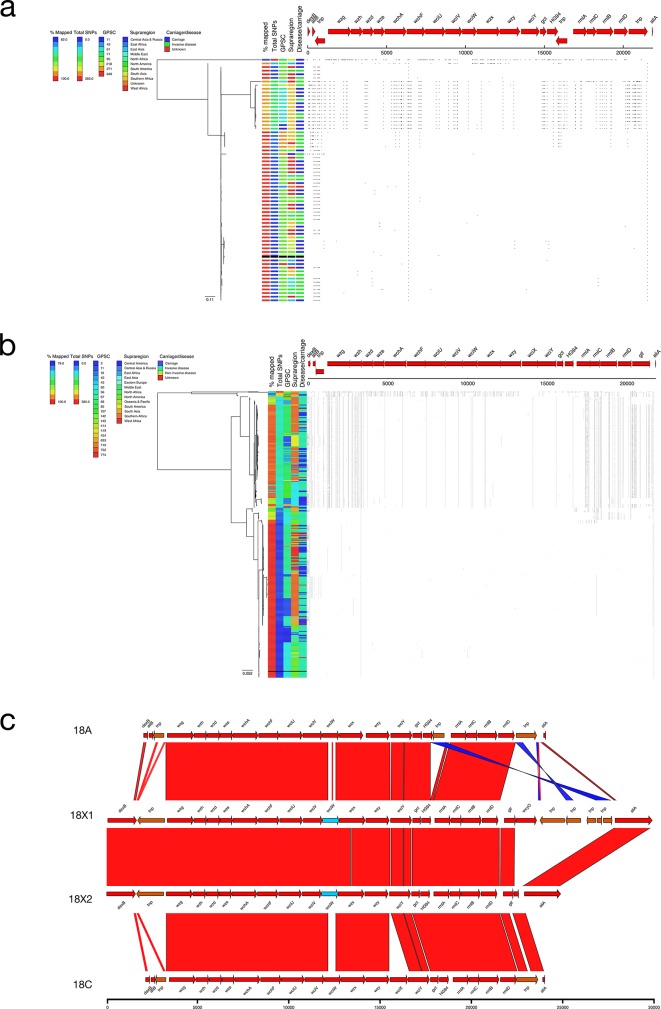
(a) Phylogeny and SNP map of serotype 18A. (b) Phylogeny and SNP map of serotype 18C. (c) Comparison of the putative serotype 18X sequences and the serotype 18A and 18C reference sequences.